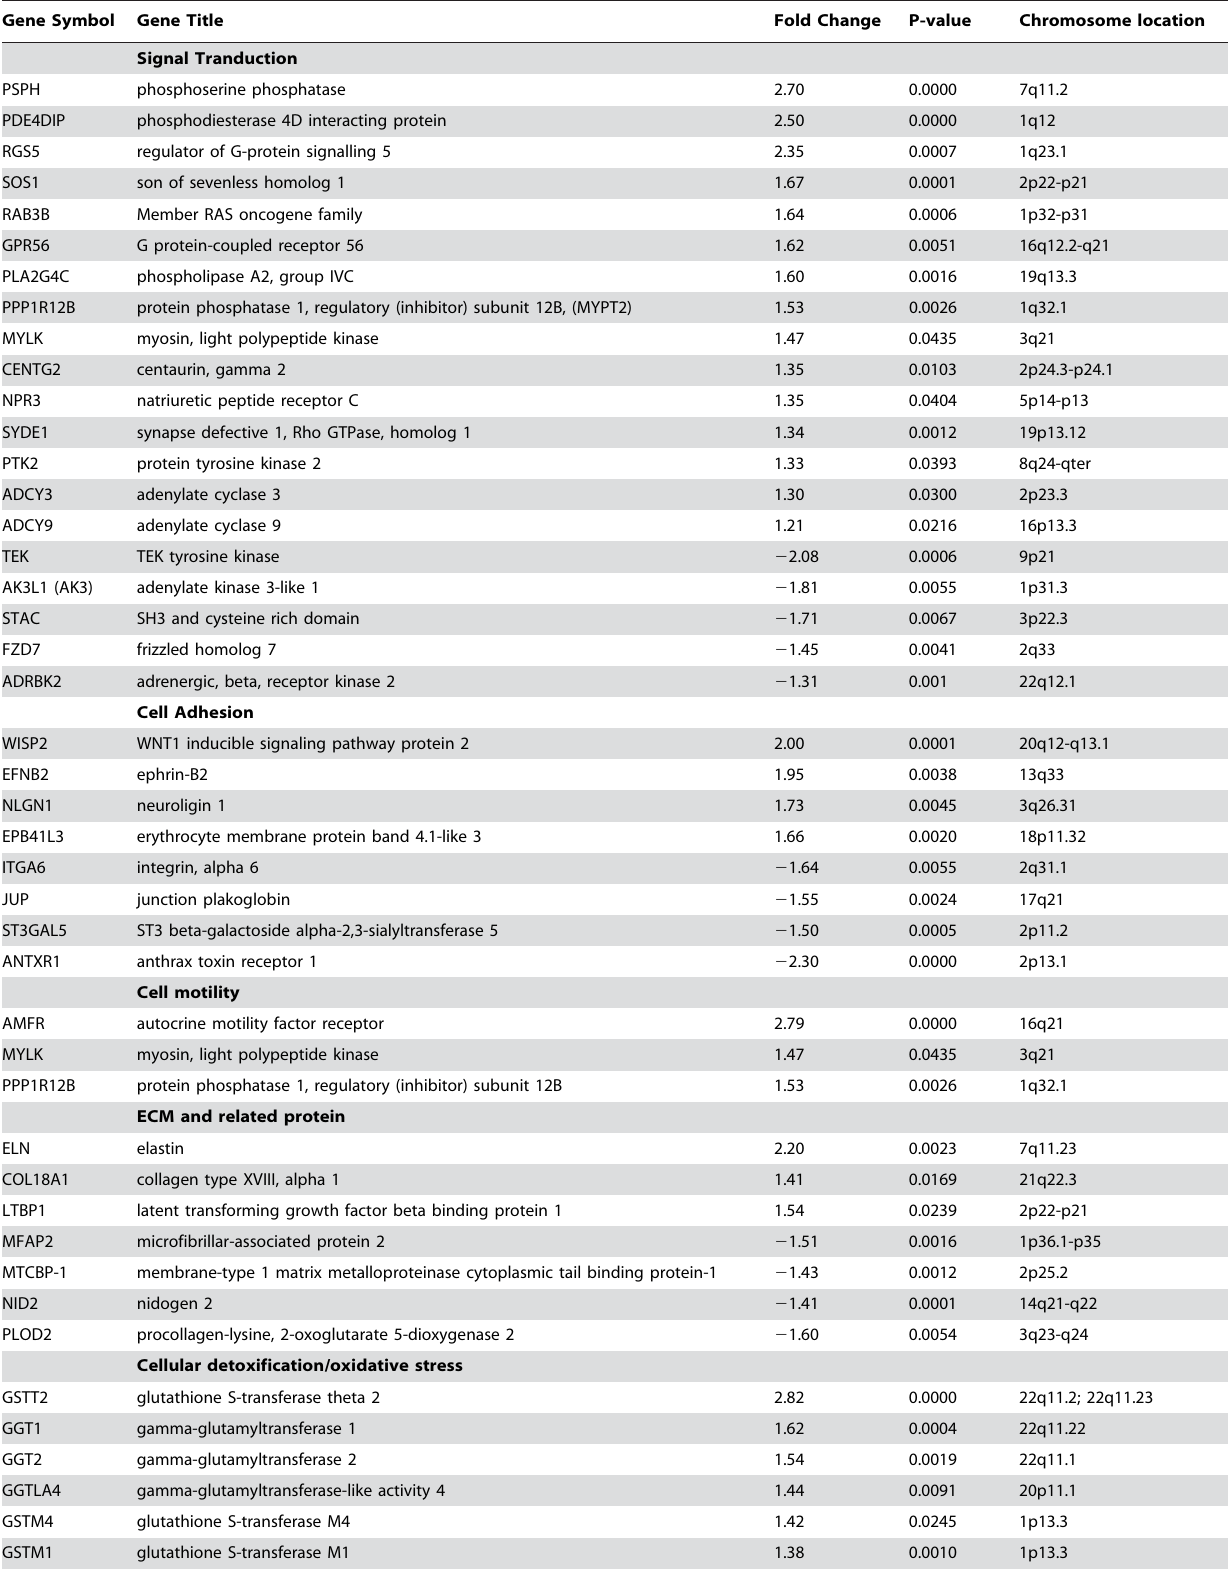
Table 1. Selected functional categories of genes differentially expressed in AA vs.